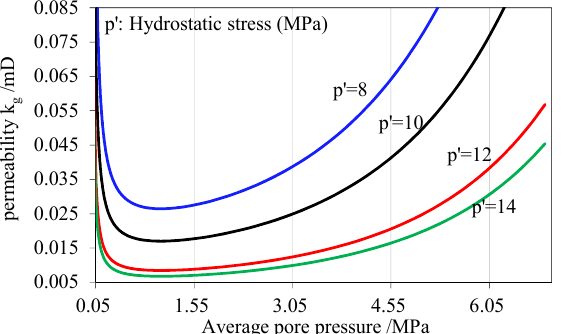
Figure 8. Permeability model calculation results under a hydrostatic stress of 8 MPa.